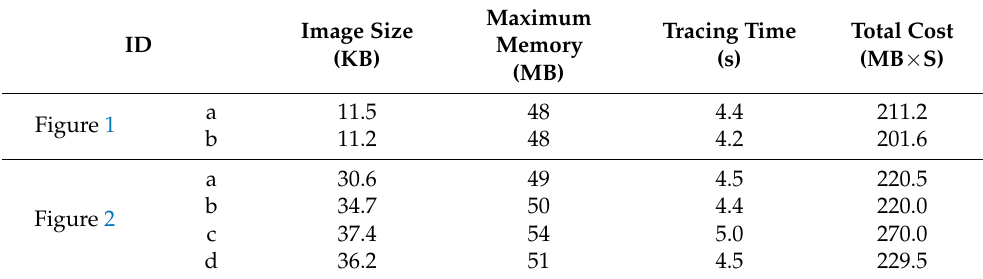
Table 3. Total computational cost for the obtained figures in Example